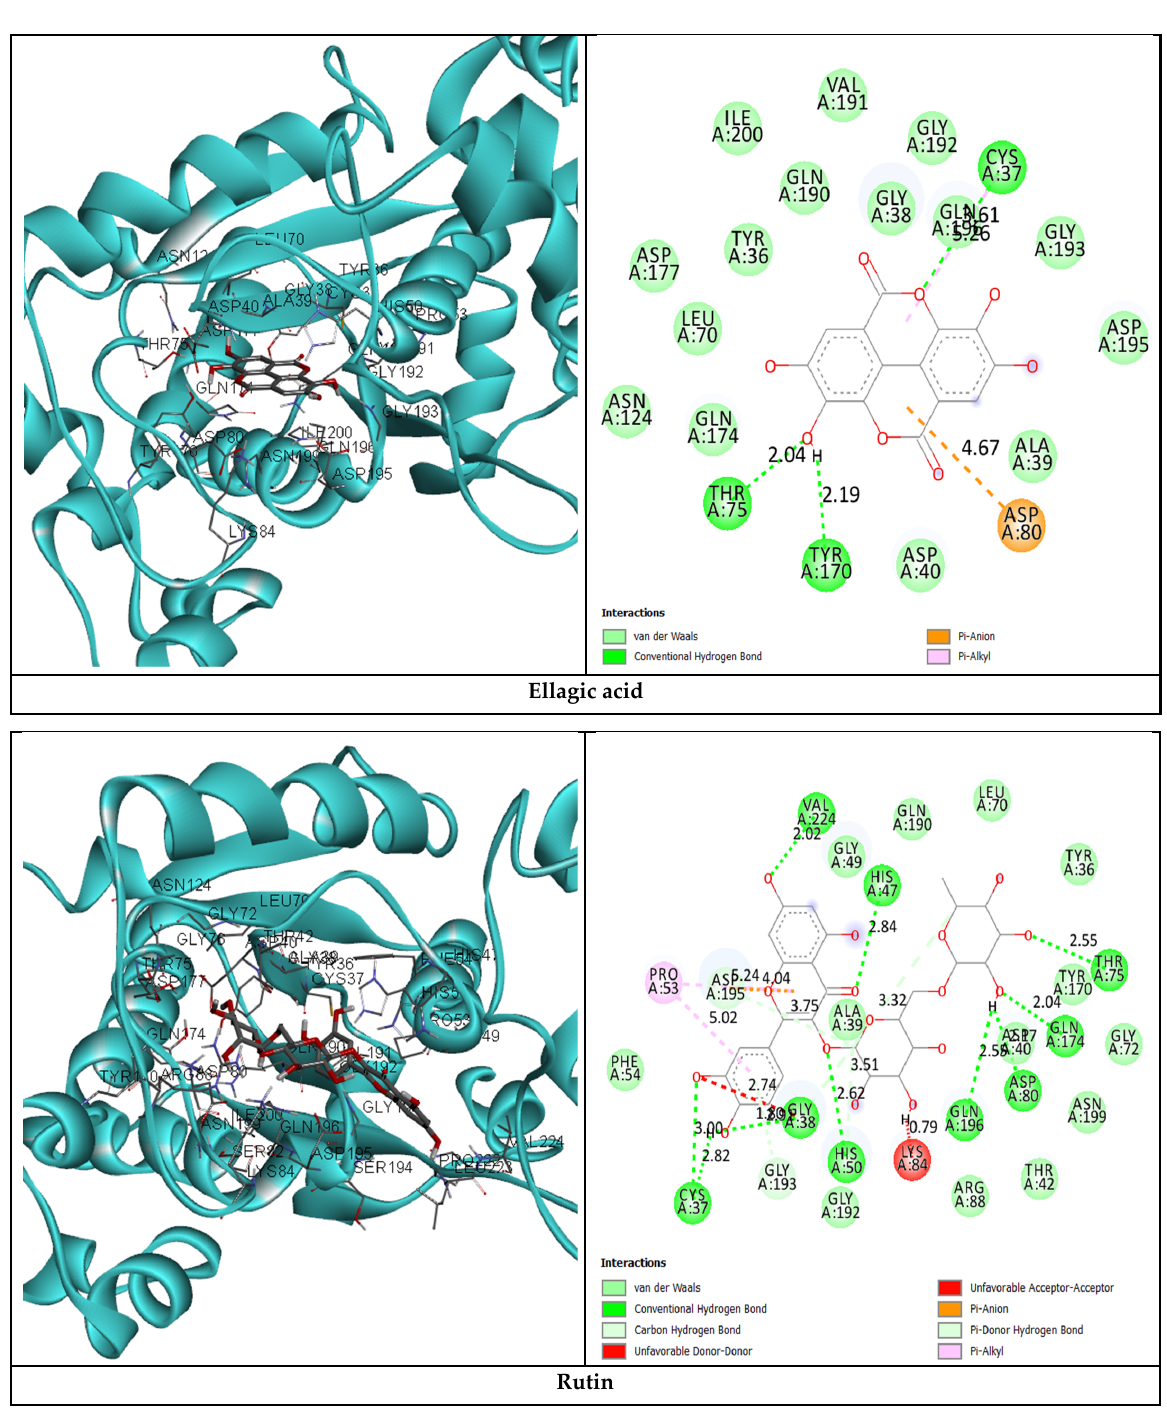
Figure 2. Two-dimensional (2D) and three-dimensional (3D) interactions of selected E. chamaesyce extract constituents with the residues of the active site of tyrosyl tRNA synthetase (PDB: 1JIJ). Ellagic acid interactions: Ellagic acid exhibited the highest binding energy ( − 10.1 kcal/mol). It presented three hydrogen bonds with Thr 75 , Tyr 170 , and Cys 37 . There was one pi-anion interaction with Asp 80 . It fits very well in the active site with many Van der Waals (vdW) interactions. As mentioned before, this molecule is the second major constituent (22%), and it seemed to contribute to the potent antimicrobial activity of the plant extract. Rutin interactions: Rutin exhibited the second-highest binding energy ( − 9.8 kcal/mol). It formed 10 hydrogen bonds with Cys 37 (2 hydrogen bonds), Gly 38 , His 50 , Gln 196 , Asp 80 , Gln 174 , Thr 75 , His 47 , and Val 224 . There were two pi-( Π )-alkyl interactions with Pro 53 . There was one pi-alkyl and one pi-hydrogen donor bond interaction with Asp 195 . The mol- ecule was also surrounded by VdW interactions. Luteolin interactions: Luteolin ( − 9.7 kcal/mol) is attached to Lys 84 by two hydrogen bonds. It is attached to Tyr 36 by one hydrogen bond. There was one pi-alkyl interaction with Leu 70 and one pi-anion interaction with Asp 80 . It also built other vdW interactions with the pocket residues. Quercetin interactions: Quercetin showed binding energy of − 9.7 kcal/mol, similar to the previous compound. It had four hydrogen bonds with Thr 75 , Lys 74 , Asp 177 , and Gln 174 . It had one pi-anion interaction with Asp 40 . It had one pi-alkyl interaction with Leu 70 . The remaining interactions were of VdW types. Gallic acid: The first major compound in the E. chamaesyce extract was found to be gallic acid, which has a binding energy of − 7.2 kcal/mol. It established two hydrogen bonds with Thr 75 and Asp 40 . It had one pi-alkyl interaction with Leu 70 . It also had many VdW interactions. These different results showed that several constituents of the extract, and in partic- ular, ellagic acid, the second major compound from E. chamaesyce extract, had a good af- finity for the active site of the enzyme and made interactions with the key residues. This suggested that these constituents contribute to the antimicrobial activity of the plant. In addition, the results showing interactions with Thr 75 , Tyr 170 , Cys 37 , Gly 38 , Leu 70 , and Asp 40